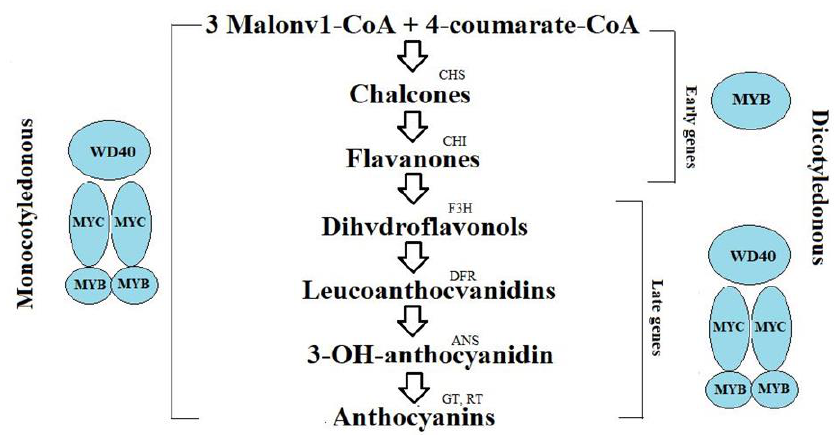
Figure 1. Biosynthesis of plant glycosides and its regulation in monocotyledonous and dicotyle- donous plants [54].